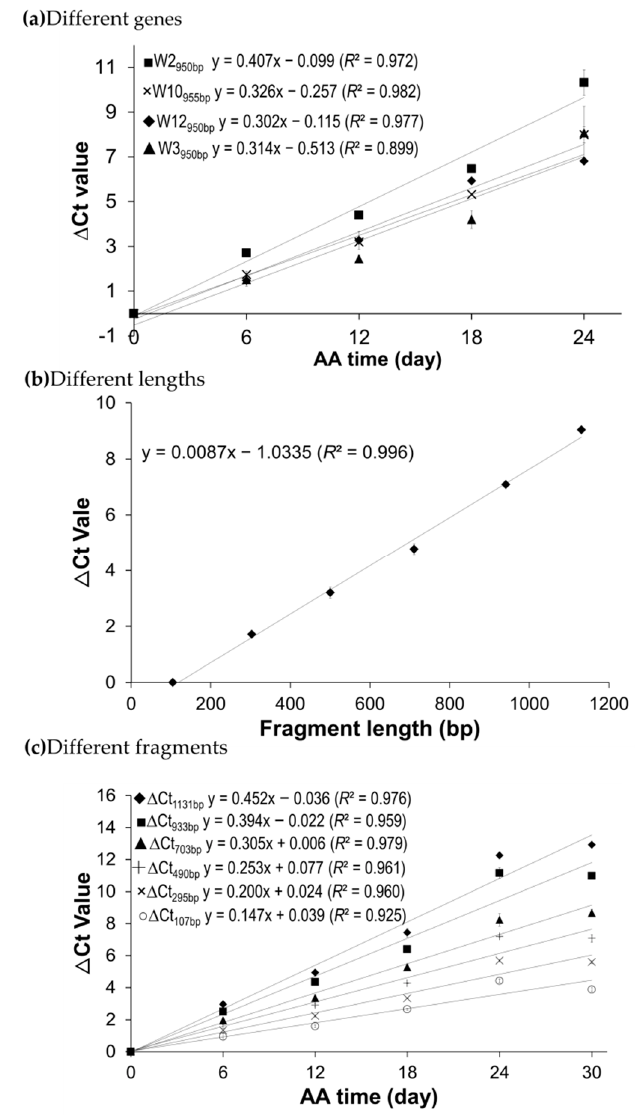
Figure 3. Relationships among the Δ Ct value, cDNA fragment size, and seed aging time as revealed from qPCR analysis of wheat seeds. ( a ) The relationship between the ∆ Ct values of stored mRNAs of four wheat mRNA genes and seed aging time. cDNAs of control and four acceleratedly aged seed samples for the indicated aging time (in days) were used. Stored mRNAs of four genes (with the fragments of W2 950bp , W3 950bp , W10 955bp , and W12 950bp ) were analyzed. ( b ) Relationship between the ∆ Ct value and cDNA fragment size of the wheat W2 gene. cDNAs of the control (100% germination) and 30-day AA seeds were used to obtain ∆ Ct values of the fragments on the W2 mRNA; the W2 fragments are W2 107bp , W2 295bp , W2 490bp , W2 703bp , W2 933bp , and W2 1131bp . ( c ) Correlation of the ∆ Ct value with seed aging time analyzed using six di ff erent cDNA fragment lengths of gene W2. cDNAs of the control and five AA seed samples under variable aging days were used, and the six W2 fragments in Figure 3b were used. Each ∆ Ct value was obtained based on three technical replicates and its standard error was shown. The linear regressions had p < 0.01 in the F -test for each of the regressions.